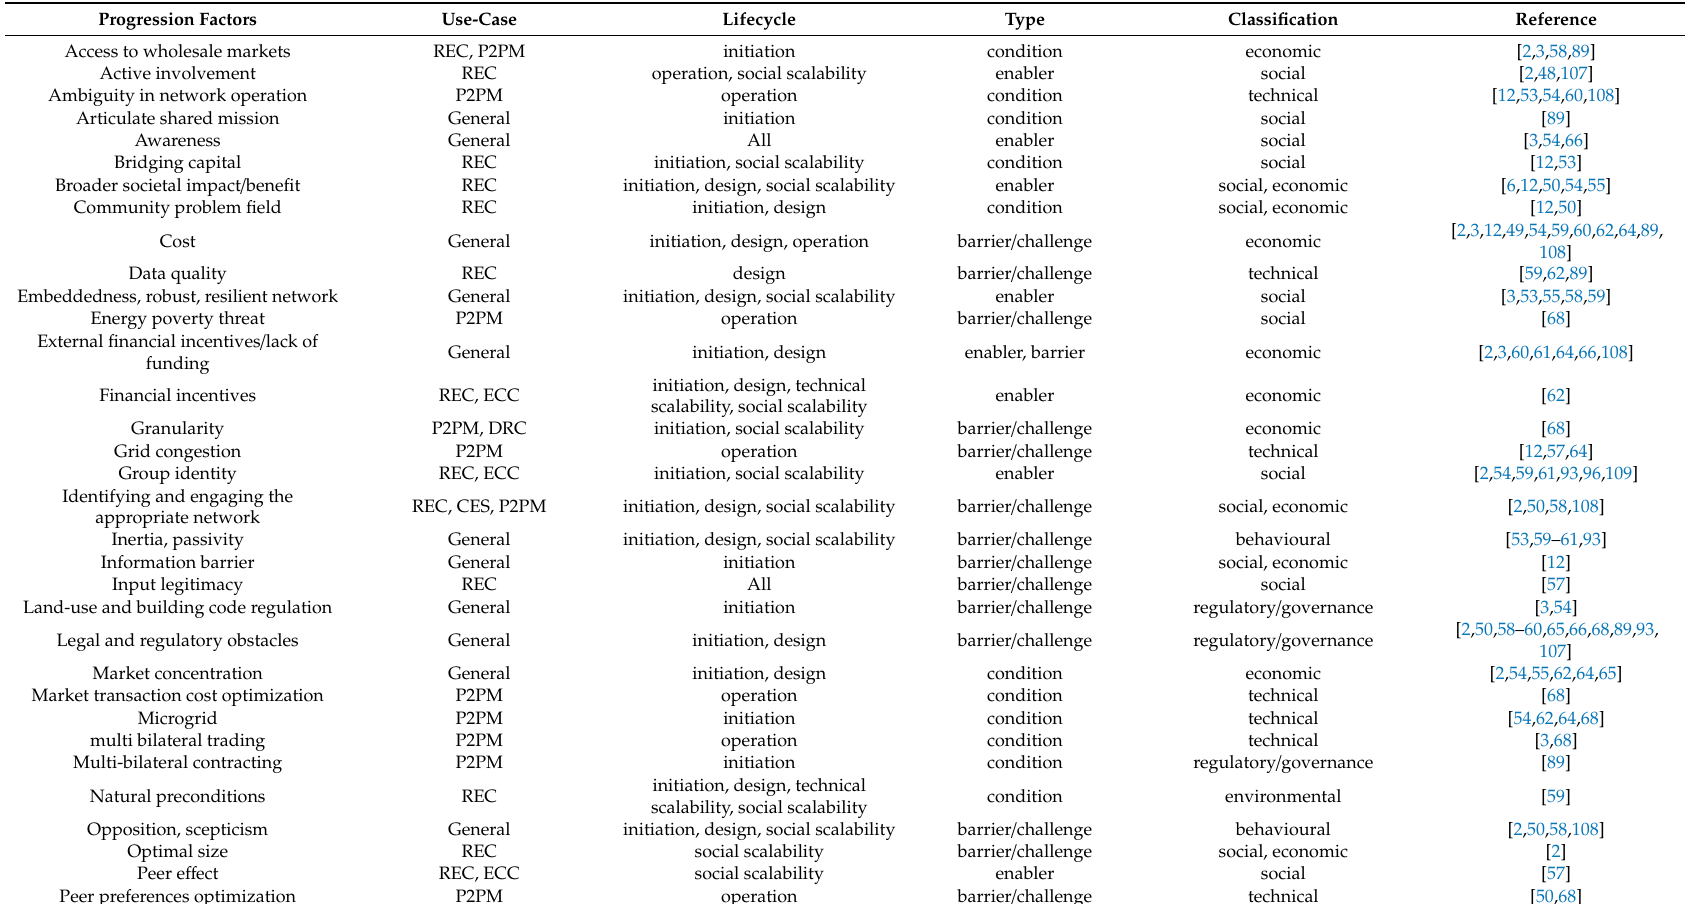
Table A1. Energy community progression